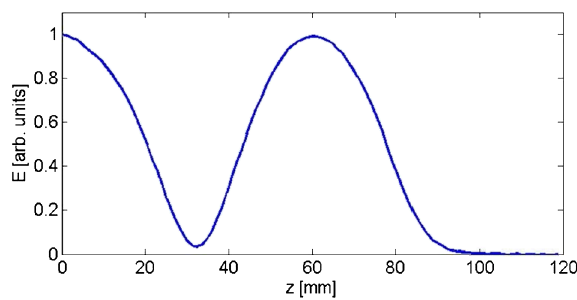
FIG. 17. Measured E field with the bead drop technique.